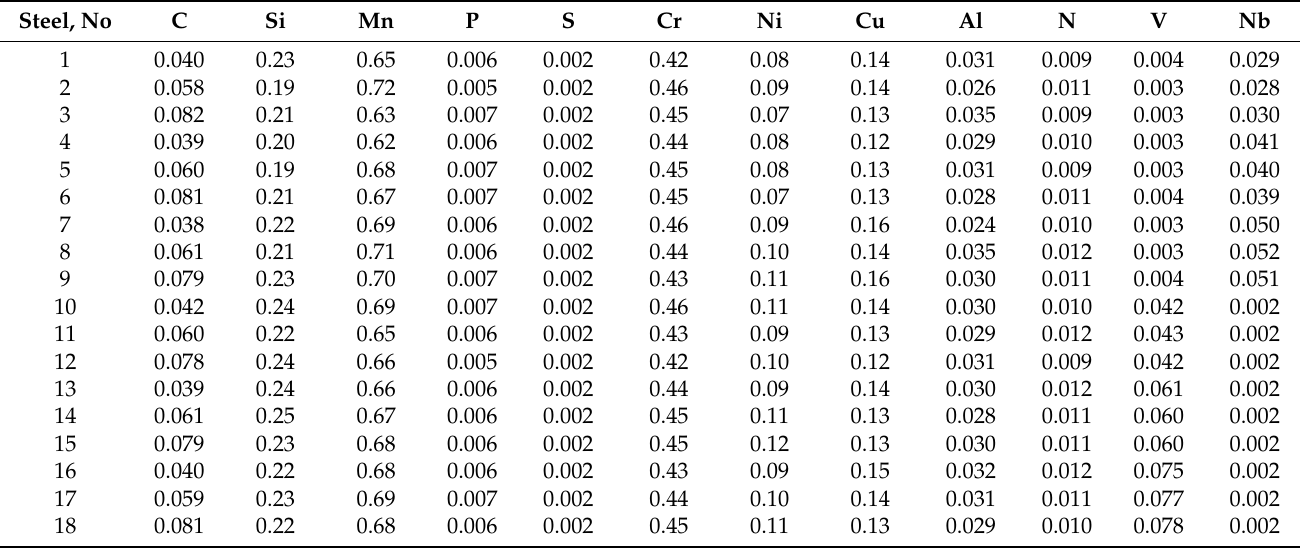
Table 1. Chemical composition of the investigated steels,